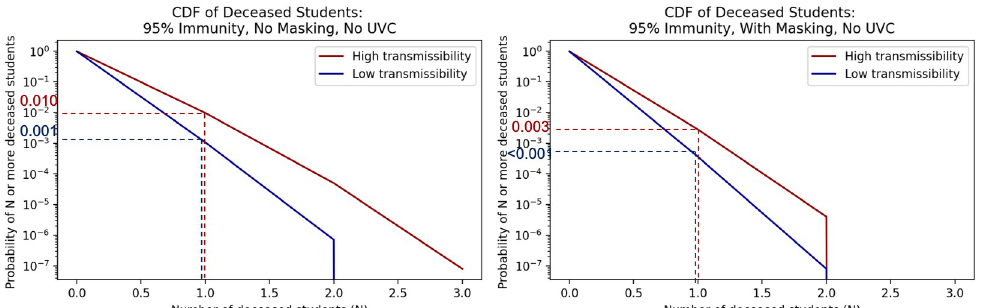
Fig 7. Inverse cumulative density functions for the total number of students that die under the different scenarios. Each graph shows the curve of the probability of exceeding a given number of deaths.